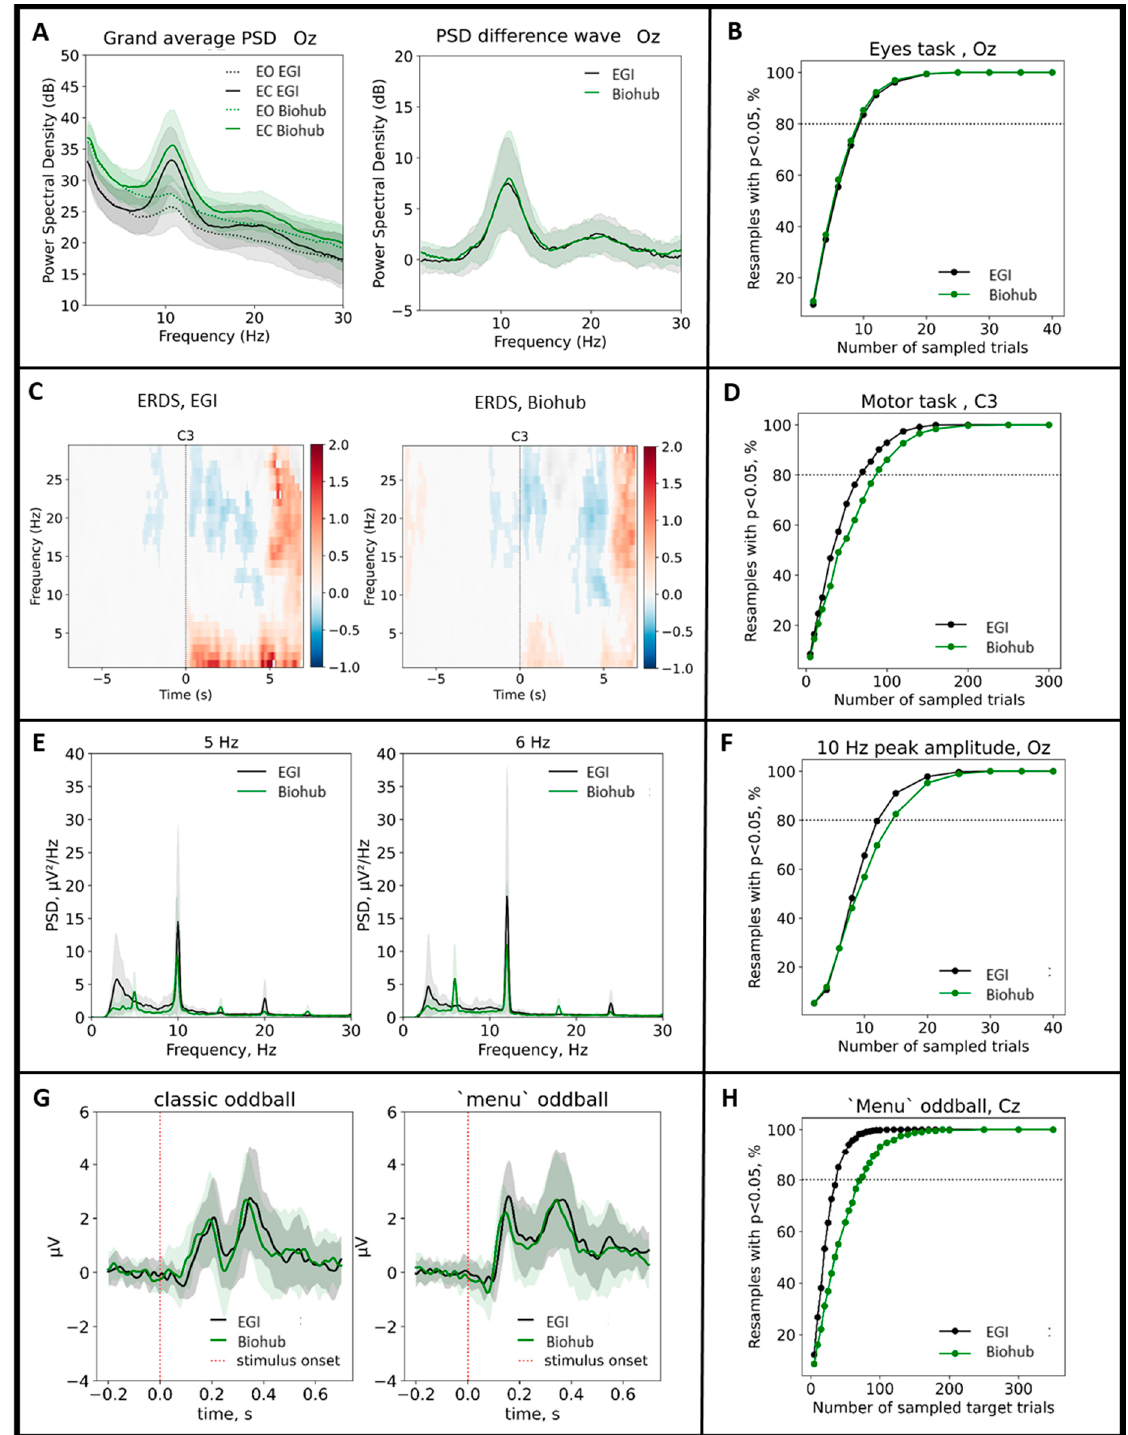
Figure 6. EEG features and corresponding statistical power computed for the eye (panels ( A , B )), motor (panels ( C , D )), SSVEP (panels ( E , F )) and oddball tasks ( G , H ) to compare the performance between the Geodesic (black) and the Biohub (green) system. Shaded colors show standard deviations around mean. Right panels report the proportion of the 1000 permutations exceeding the signifi- cance threshold as a function of the number of trials in each permutation. The PSD values at 10 Hz for the Oz channel measured during the eyes open-closed task with the Biohub and EGI systems exceeded significance on 80% of permutations (80% power dashed line) with equal numbers of trials (Biohub and EGI trials = 10). Similar consideration can be